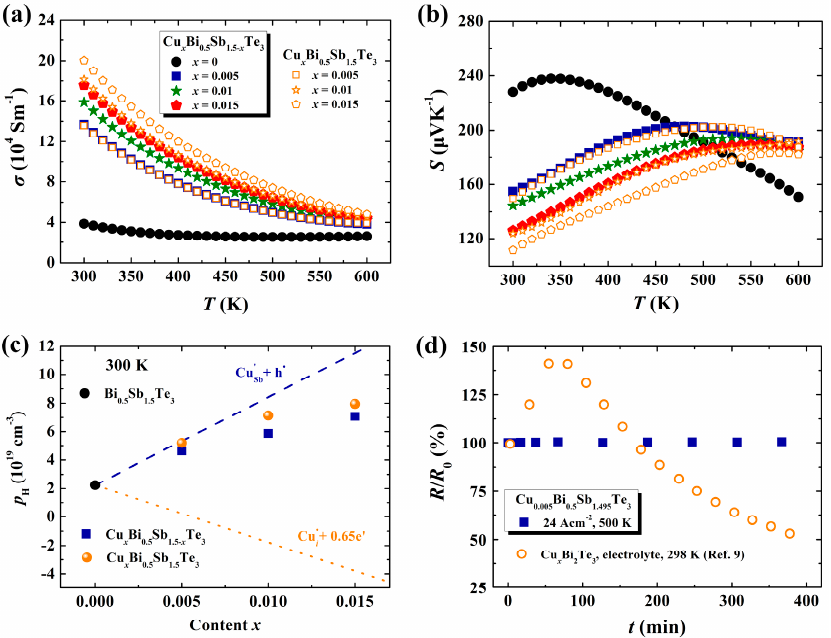
Figure 3. Temperature dependences of ( a ) electrical conductivity σ and ( b ) Seebeck coefficient S for nominal Cu-doped Cu x Bi 0.5 Sb 1.5- x Te 3 samples and nominal Cu-intercalated Cu x Bi 0.5 Sb 1.5 Te 3 samples. The σ and S data for Cu x Bi 0.5 Sb 1.5- x Te 3 ( x = 0, x = 0.005) are taken from [8]; ( c ) The measured Hall hole concentration p H at 300 K as a function of the nominal Cu content x for all Cu x Bi 0.5 Sb 1.5- x Te 3 and Cu x Bi 0.5 Sb 1.5 Te 3 samples. The dashed and dotted lines represent the predicated p H curves by assuming the Cu atoms at Sb sites and at the van der Waals gap, respectively; ( d ) Relative resistance R / R 0 for Cu 0.005 Bi 0.5 Sb 1.495 Te 3 sample under the current density of 24 Acm − 2 at 500 K. The data of Cu-intercalated p-type Bi 2 Te 3 reported by McCarthy et al. are also shown for comparison [9].